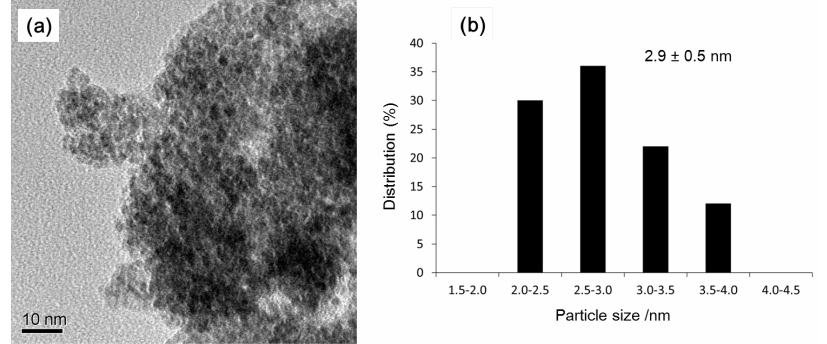
Figure 5. ( a ) TEM micrograph of the recovered catalyst (scale bar = 10 nm); ( b ) size distribution of the recovered